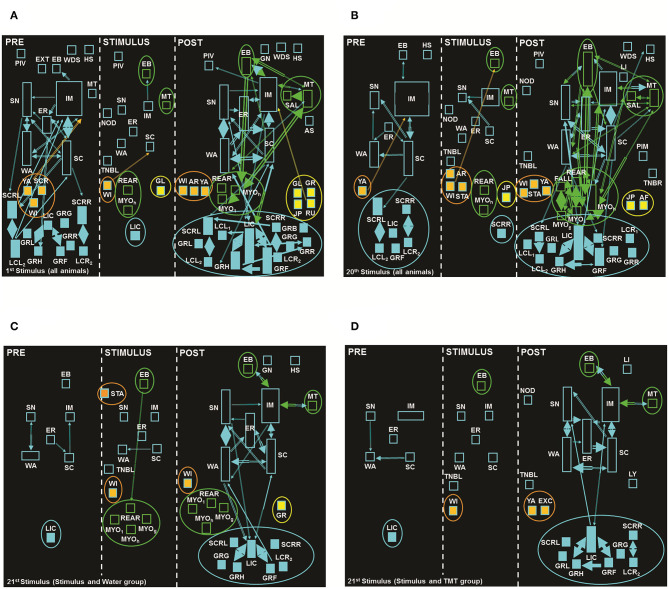
Flowcharts with the sum of seizures from the (A) 1st and (B) 20th stimuli of animals both stimulated groups. (C) and (D) are the flowcharts from the 21st stimulus: (C) Stimulus and Water, and (D) Stimulus and TMT. In the first cell (left) of each stimulus, the PRE period with 5 min before stimulus (exception: 21st stimulus with a duration of 20 s); in the second cell (middle), the STIMULUS period with 10 s, and finally in the third cell (right), the POST-period also with a duration of 5 min after the stimulus. Calibration details such as rectangles, arrows, and colors; see Figure 1A. Behavioral dictionary and acronyms: AF, Atonic Falling; AR, Arousal; AS, Abdominal Spasms; EB, Eye Blinking; ER, Erect Posture; EXT, Extension; FALL, Falling; GL, Gyrating, Left; GN, Gnawing; GR, Gyrating, Right; GRB, Grooming; GRF, Grooming of Face; GRG, Grooming of Genitals; GRH, Grooming of Head; GRL, Grooming of Body, Left; GRR, Grooming of Body, Right; IM, Immobility; JP, Jumping; LCL1, Licking of Claws Left, Forelegs; LCL2, Licking of Claws Left, Hindlegs; LCR1, Licking of Claws Right, Forelegs; LI, Licking; LIC, Licking of Claws; MT, Masticatory Movements; MYO1, Myoclonus Spasms, Forelegs; MIOg, Generalized Myoclonus; MYOh, Myoclonus Spasms, Head; NOD, Nodding; PIM, Postictal Immobility; PIV, Pivoting; REAR, Rearing; RU, Running; SAL, Salivation; SC, Scanning; SCRL, Scratching of Body, Left; SCRR, Scratching of Body, Right; SH, Head Shaking; SN, Sniffing; STA, Startle; TNBL, Tonic Neck and Body Turning Left; TNBR, Tonic Neck and Body Turning Right; WA, Walking; WDS, Wet Dog Shaking; WI, Withdraw; YA, Yawning (the complete list of acronyms is summarized in Supplementary Table 1).